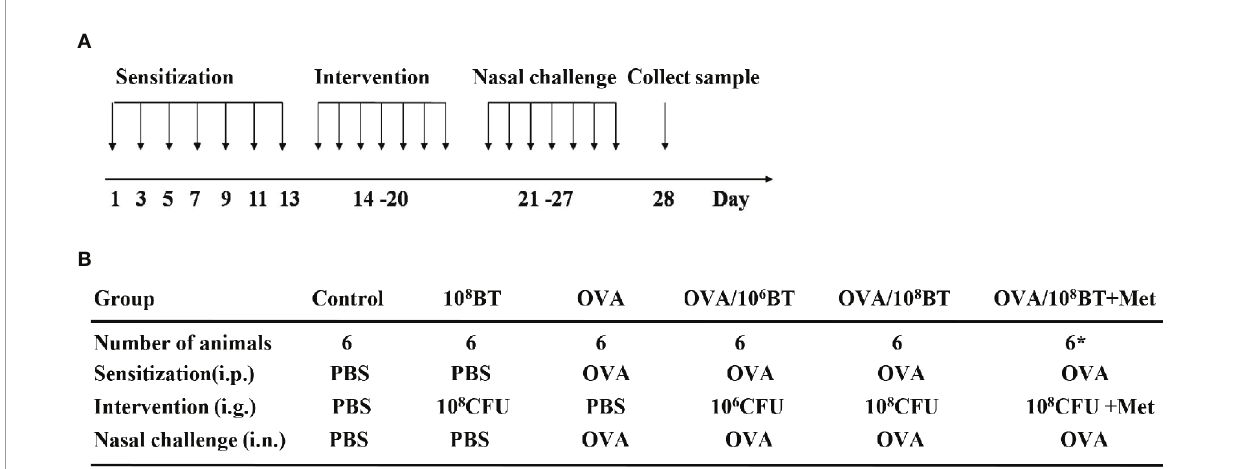
FIGURE 1 | The experimental protocol (A) and different groups (B) . Mice were given B. thetaiotaomicron daily from Day 14 – 20, with OVA-sensitization on Day 1, 3, 5, 7, 9, 11, and 13, and nasal challenge with 5% OVA from Day 21 – 27. Then mice were sacri fi ced on Day 28 to collect tissues or samples for experimental analysis. Mice were divided into six different groups in this work. Each experimental group consisted of six